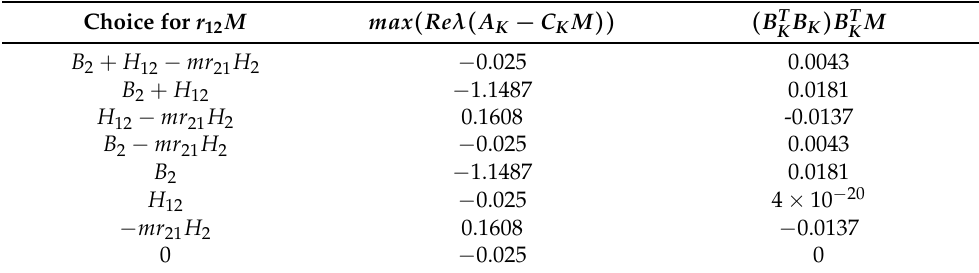
Table 2. Selection of the anti wind-up gain.